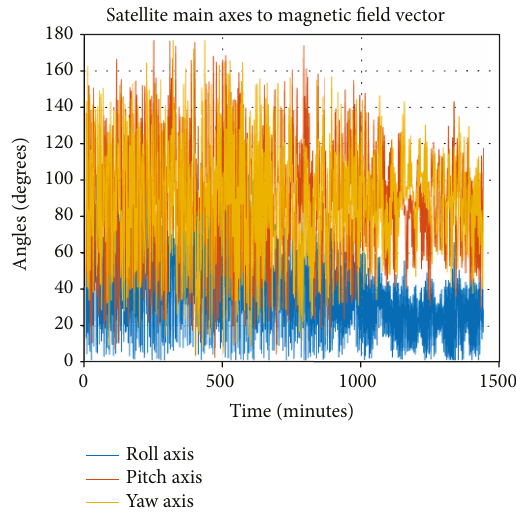
Figure 12: Simulated 3U CubeSat at ISS orbit including aerodynamic torques, using, however, half the volume of magnetic hysteresis material as in Figure 10. Attitude response is notably worse in terms of tracking the magnetic fi eld vector. This illustrates the sensitivity to the amount of hysteresis material used and the importance of careful